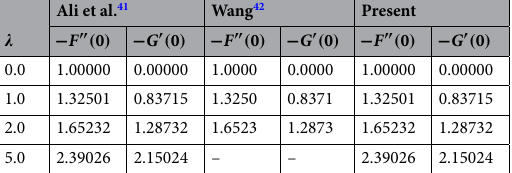
G F ′ ( 0 ) and − ′′ ( 0 ) for various values of −